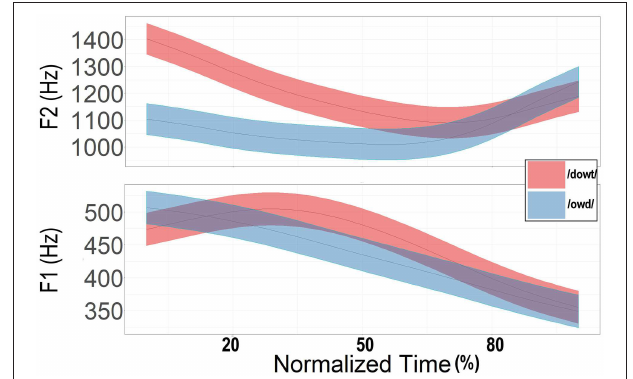
FIGURE 6 | Plots of SSANOVA for /o w d/ (blue) vs. /do w t/ (pink).